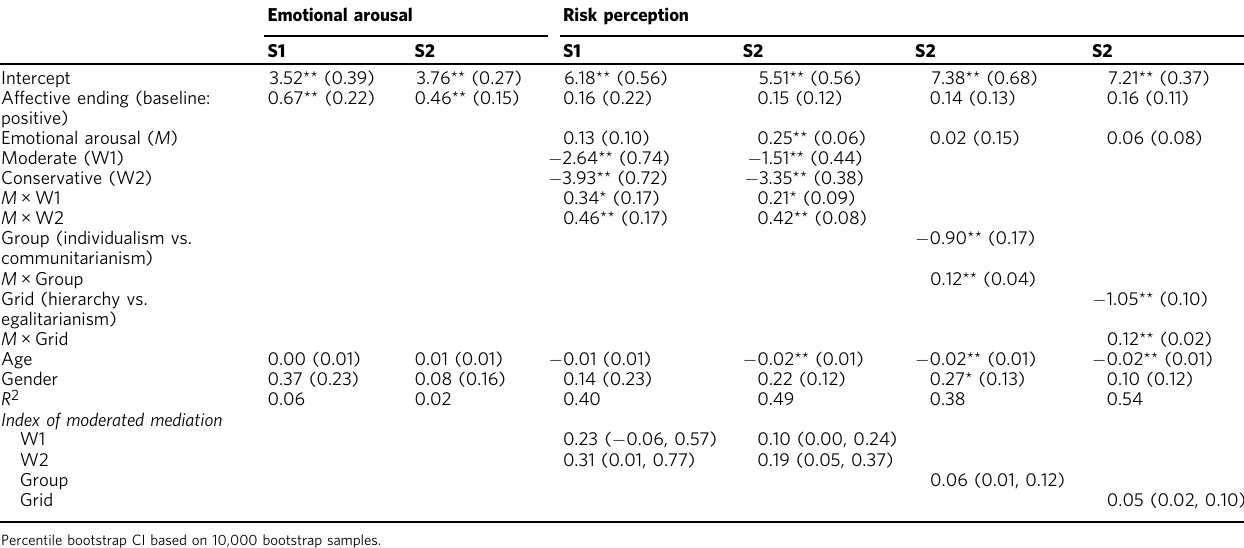
Table 1 Results of conditional process analysis (moderated mediation model), Studies 1 and